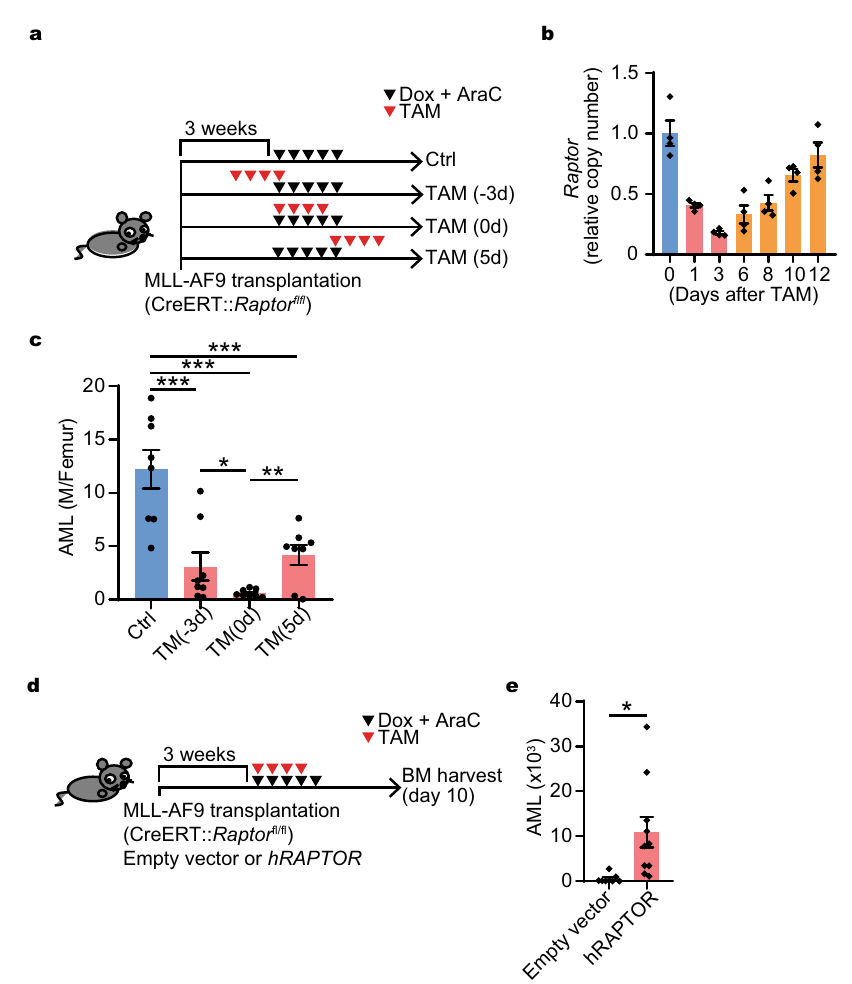
Fig. 5 Timed inhibition of mTORC1 with chemotherapy improved AML burden. a Experimental design of mTORC1 timed inhibition in combination with chemotherapy. MLL-AF9 cells (GPF + , CreERT::Rptor fl / fl ) were transplanted 3 weeks before the start of chemotherapy (Dox + Ara-C), which was started day 0 with (TAM) or without (Ctrl) Tamoxifen (TAM for 4 days started at day − 3, 0, or 5). b Kinetics of Raptor deletion ef fi ciency days before (day 0) and after starting the 4 days of Tamoxifen (TAM) treatment (day 1, 3, 6, 8, 10, and 12) ( n = 4). c AML burden with or without inducible Raptor deletion in combination with chemotherapy ( n = 8). d Experimental design of retroviral transduction of hRAPTOR for rescue of Raptor deletion: The number of AML cells was evaluated at day 10 after initiation of chemotherapy (Dox + AraC). e AML burden with or without rescue: AML cell number per femur was evaluated. Empty vector and hRAPTOR were transfected (empty vector: n = 8, hRAPTOR n = 10). b – c , e Representative data from two independent experiments were shown. Mean± SEM was shown in bar pot (each dot represents each sample). Statistical analysis was performed by using two-way t -test ( e ) and paired t -test ( b , c ) (* p < 0.05, ** p < 0.01, *** p <